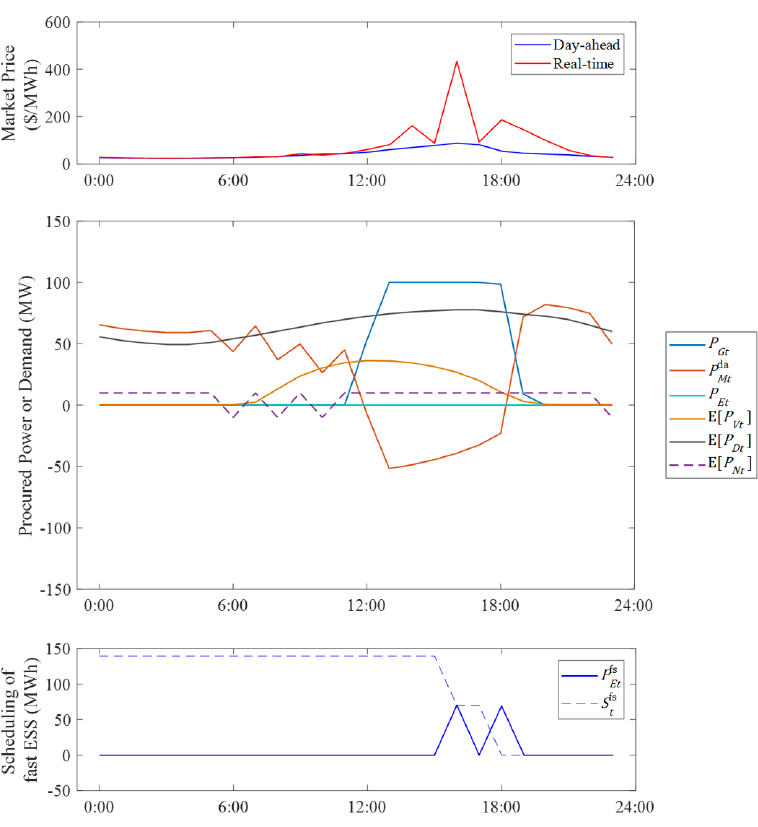
Figure 8. Procurement on 20 July